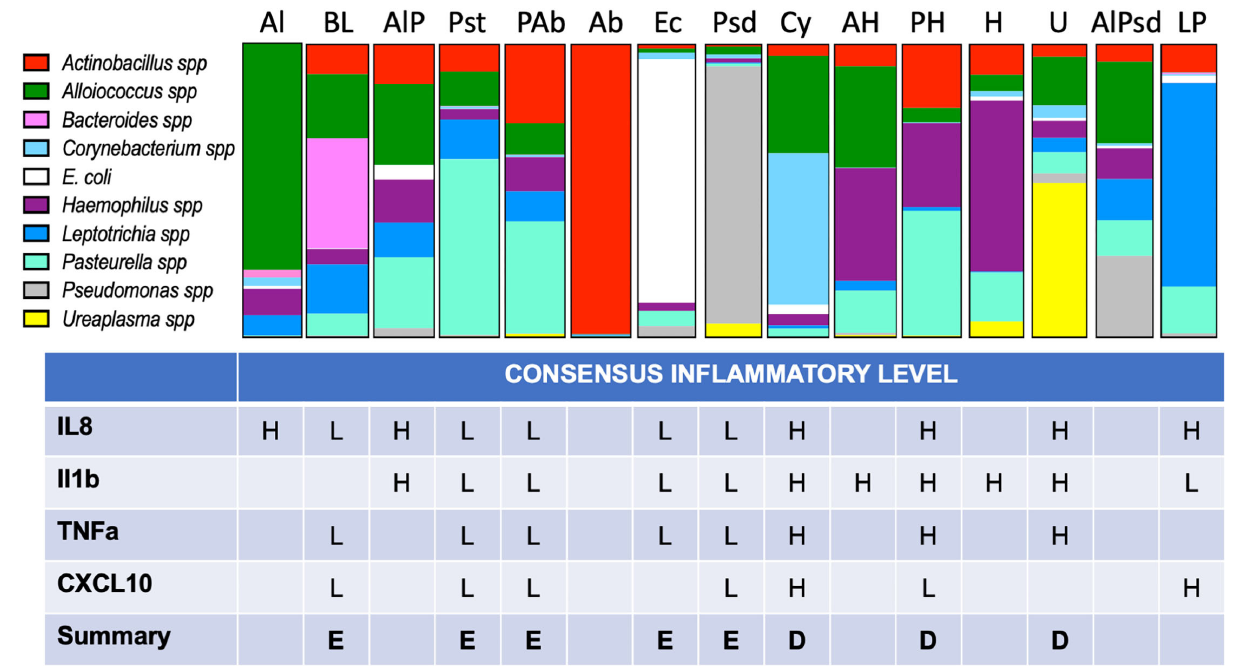
FIGURE 5 | Proportional bar charts represent the average VMB community structure for each of the identified CTs and their inflammatory association. Top: The 10 identified biomarker organisms were proportionally charted to illustrate the average profiles from the 216 vaginal swab samples evaluated from phase 3 of the study. The number of representatives is shown below each bar. Bottom: Using the assigned CT, each of the individual swab samples was grouped (one sample was not typable by this system) and designated by one of several models of inflammation as described in the results. Using enzyme-linked immunosorbent assay (ELISA) data ( Figure 6 ), we considered binary and tertile categorization schemes derived from all the samples regardless of CT for the four commonly detected targets. Using the binary distinctions of high (H) or low (L), assignments were made when at least 67% of the samples fell in one category. A final call of eubiotic (E) or dysbiotic (D) was made when at least three of the four targets showed